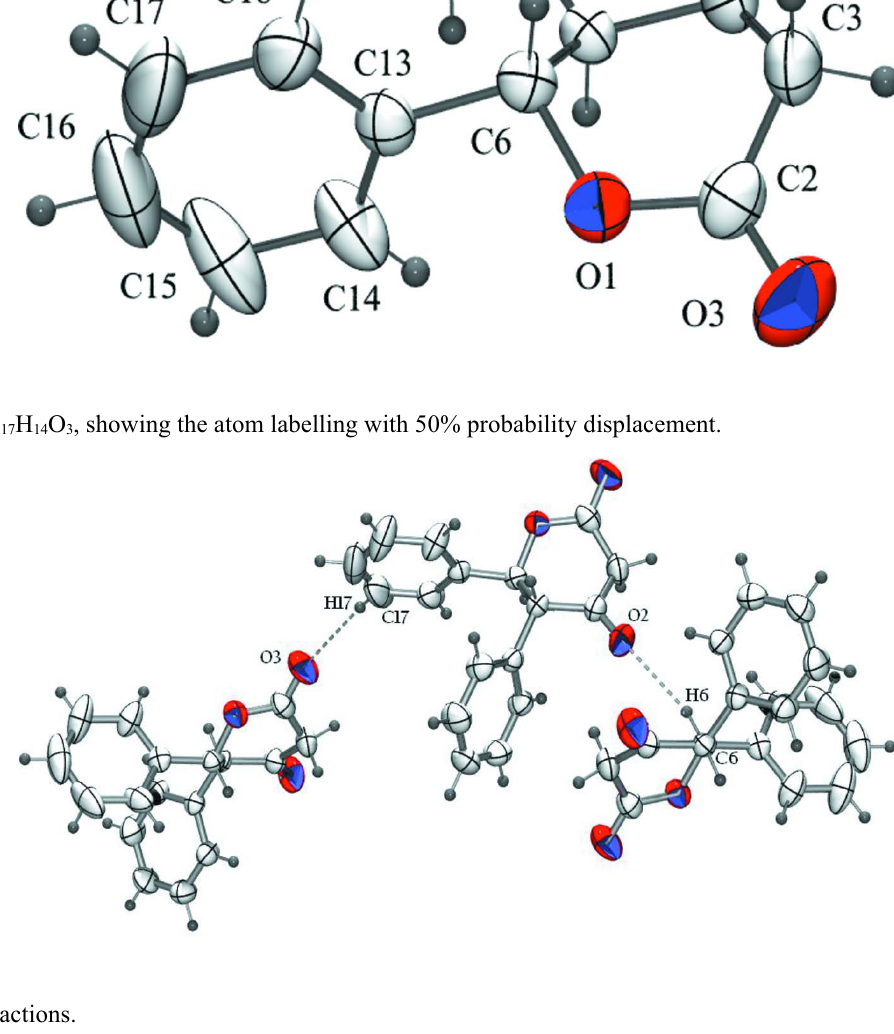
Figure 2 Hydrogen